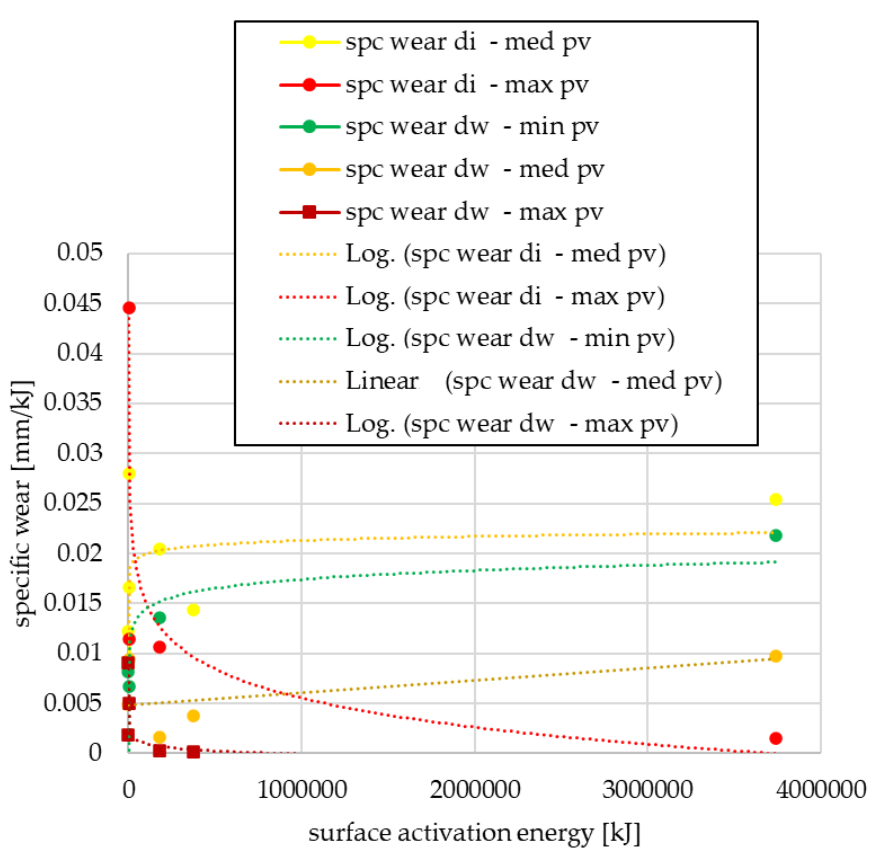
Figure 9. Specific wear values as a function of surface activation energy — clutch killer facings.